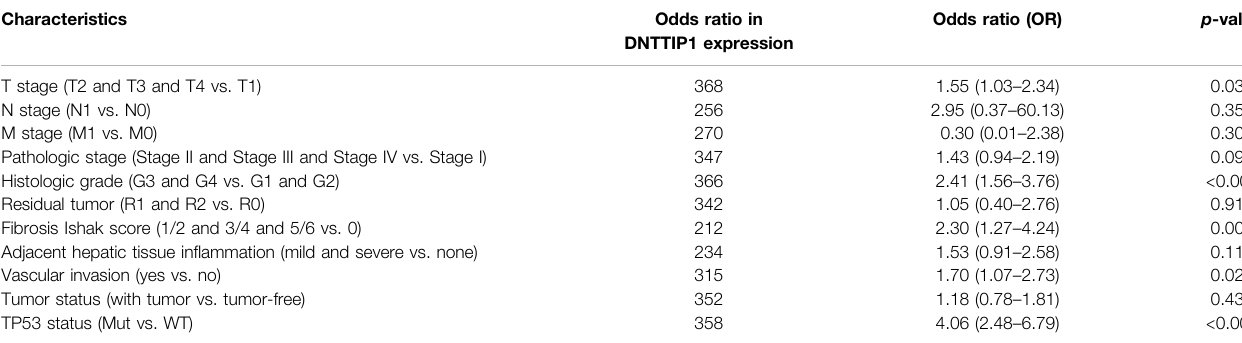
Odds ratio (OR) p -value DNTTIP1 expression